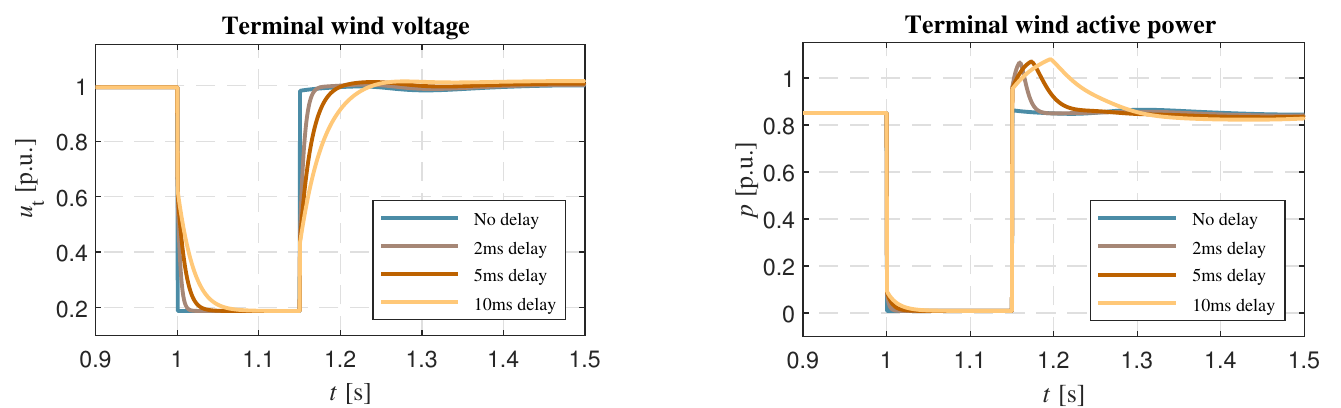
Dynamic response of the wind turbine to the fault considering different delay time constants T del for the monolithic